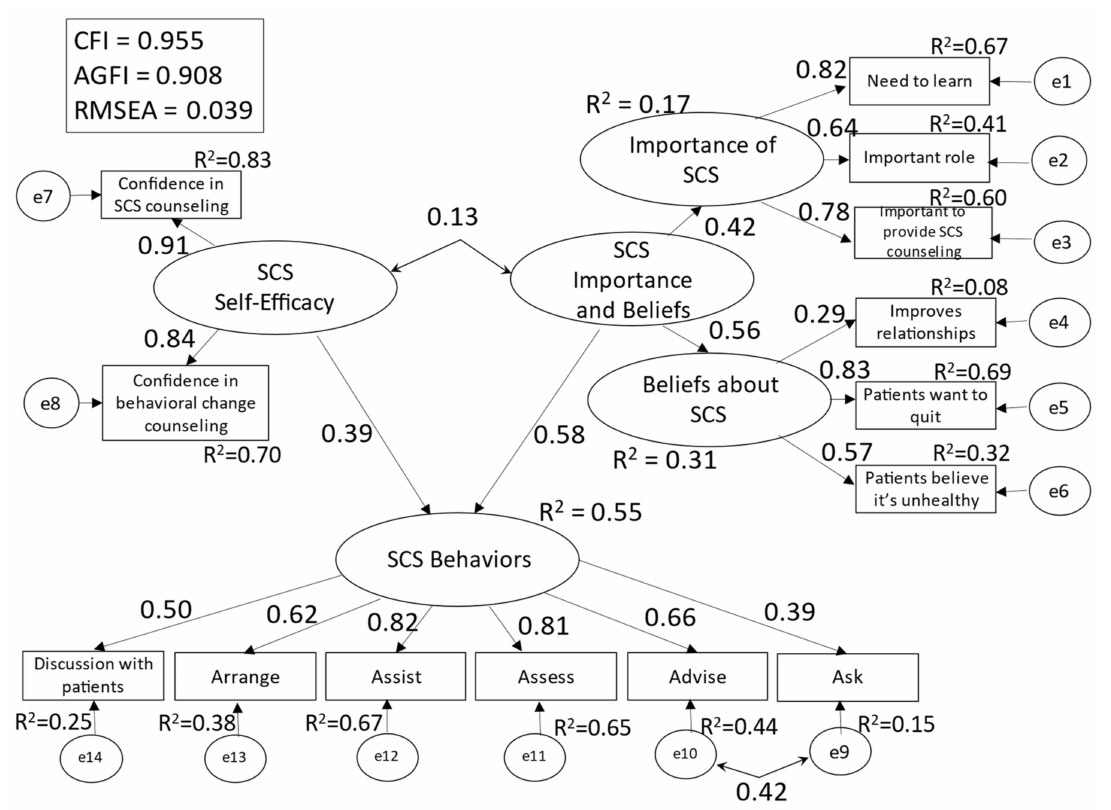
Figure 2. Conceptual Model 2 (SCS